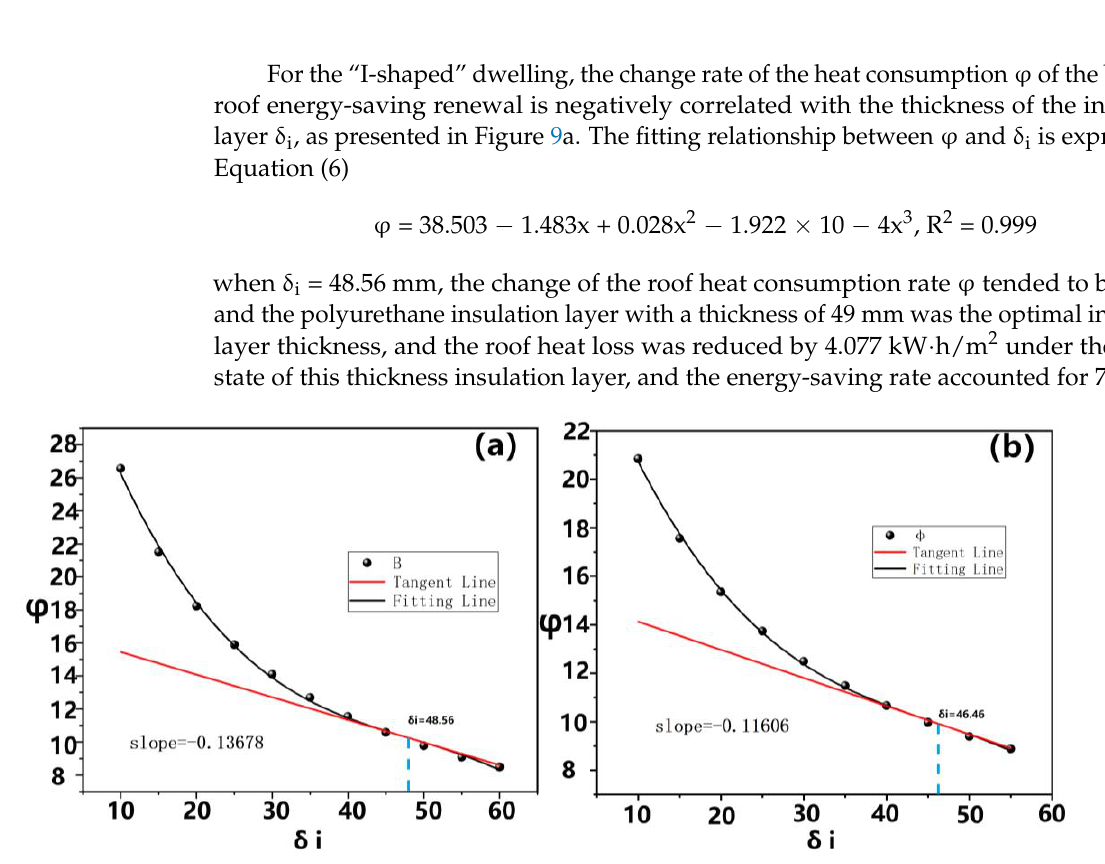
Figure 9. The impact of thickness on the roof energy-saving rate: ( a ) Roof energy- saving rate of “I - shaped” dwelling; ( b ) Roof energy- saving rate of “L - shaped” dwelling.